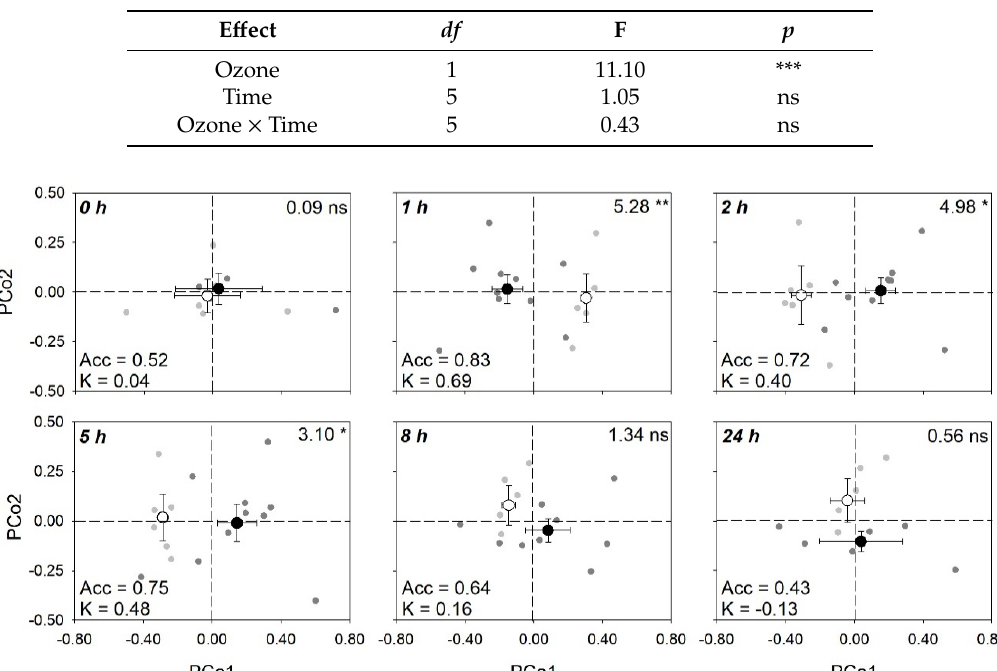
Table 2. F- and p -values of two-way permutational multivariate analysis of variance (PERMANOVA) for the e ff ects of ozone, time, and their interaction on full-range (400–2400 nm) reflectance profiles of sage leaves. df represents the degrees of freedom. *** p ≤ 0.001, ns: p > 0.05.